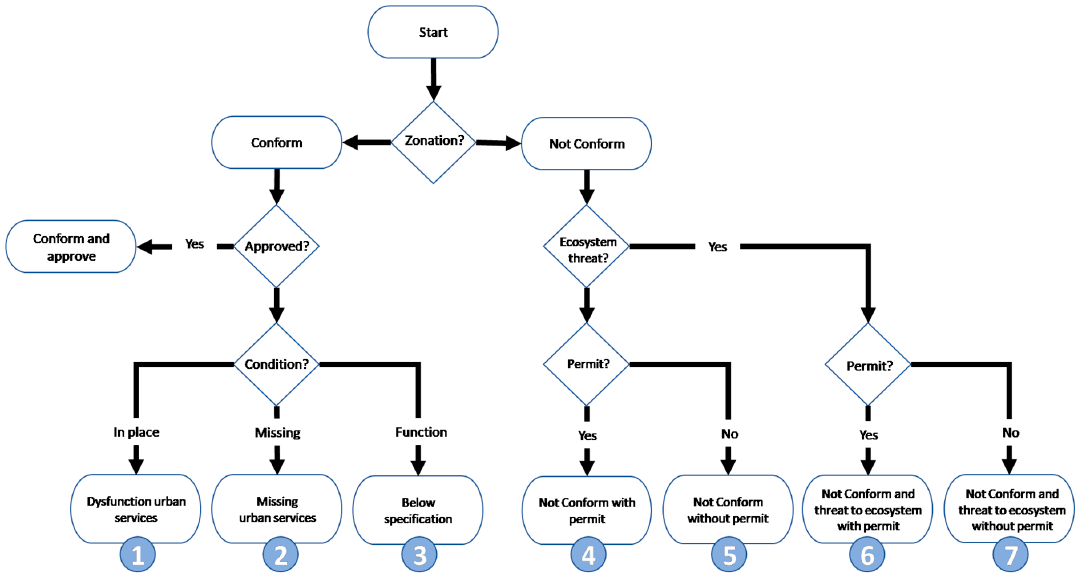
Figure 6. The workflow of conformance checking for urban planning monitoring derived from the Indonesian Government Regulation No. 15 Year 2010 [64] .